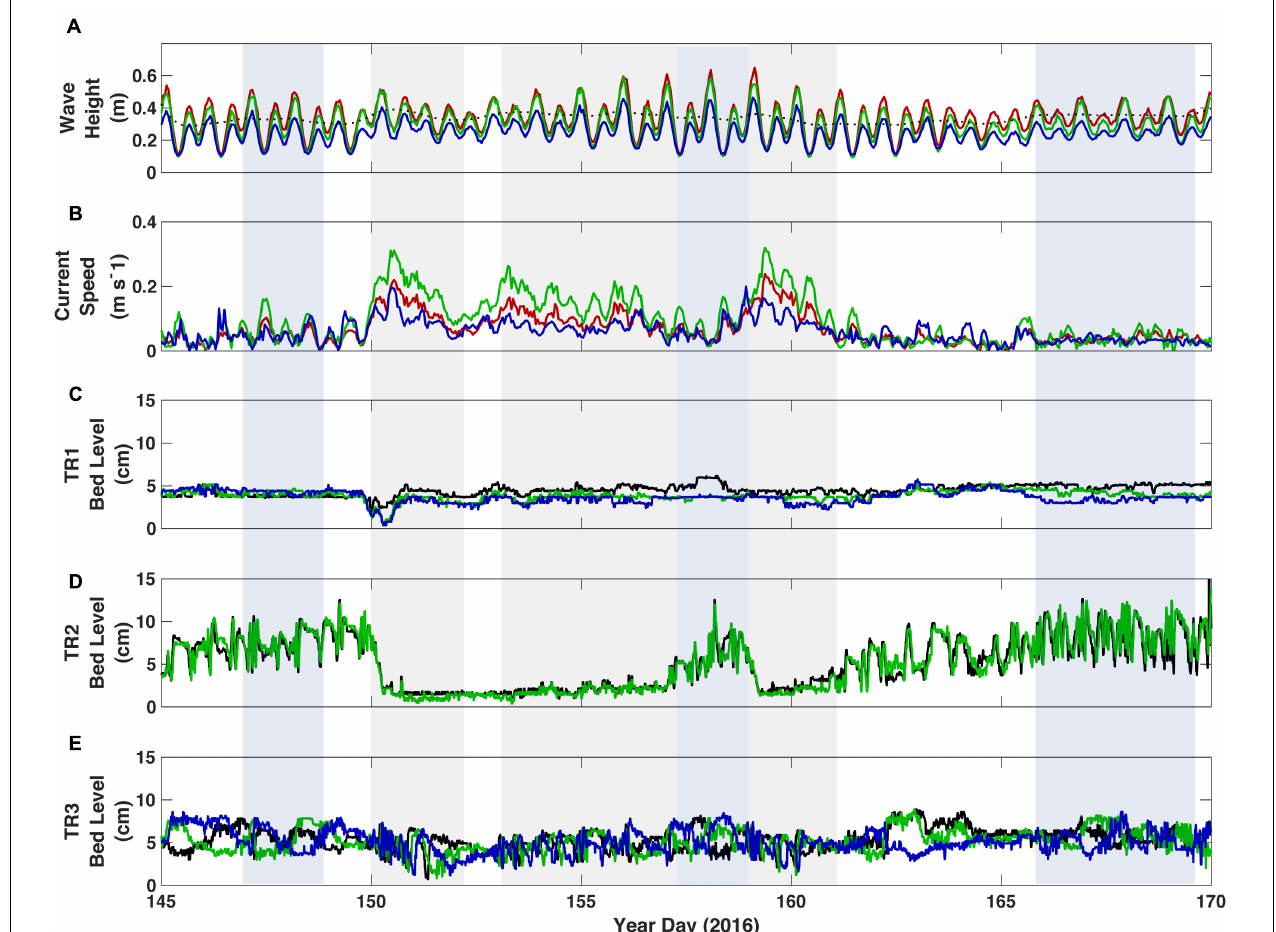
FIGURE 6 | Response of the reef to forcing. (A) Significant wave height; the black dotted line denotes the 40-h low-pass filtered wave height at TR1. (B) Depth-averaged current speed. (C) Bed elevation from the three in-line altimeters at TR1 on the outer reef flat near the reef crest. (D) Bed elevation from the two in-line altimeters at TR2 on the inner reef flat. (E) Bed elevation from the three in-line altimeters at TR3 in the lagoon. In A and B, color represents the site location: Red = TR1 on the outer reef flat near the reef crest, blue = TR2 on the inner reef flat, and green = TR3 in the lagoon. In panels (C–E) colors represent data from individual altimeters, in order from offshore to onshore, black, green and